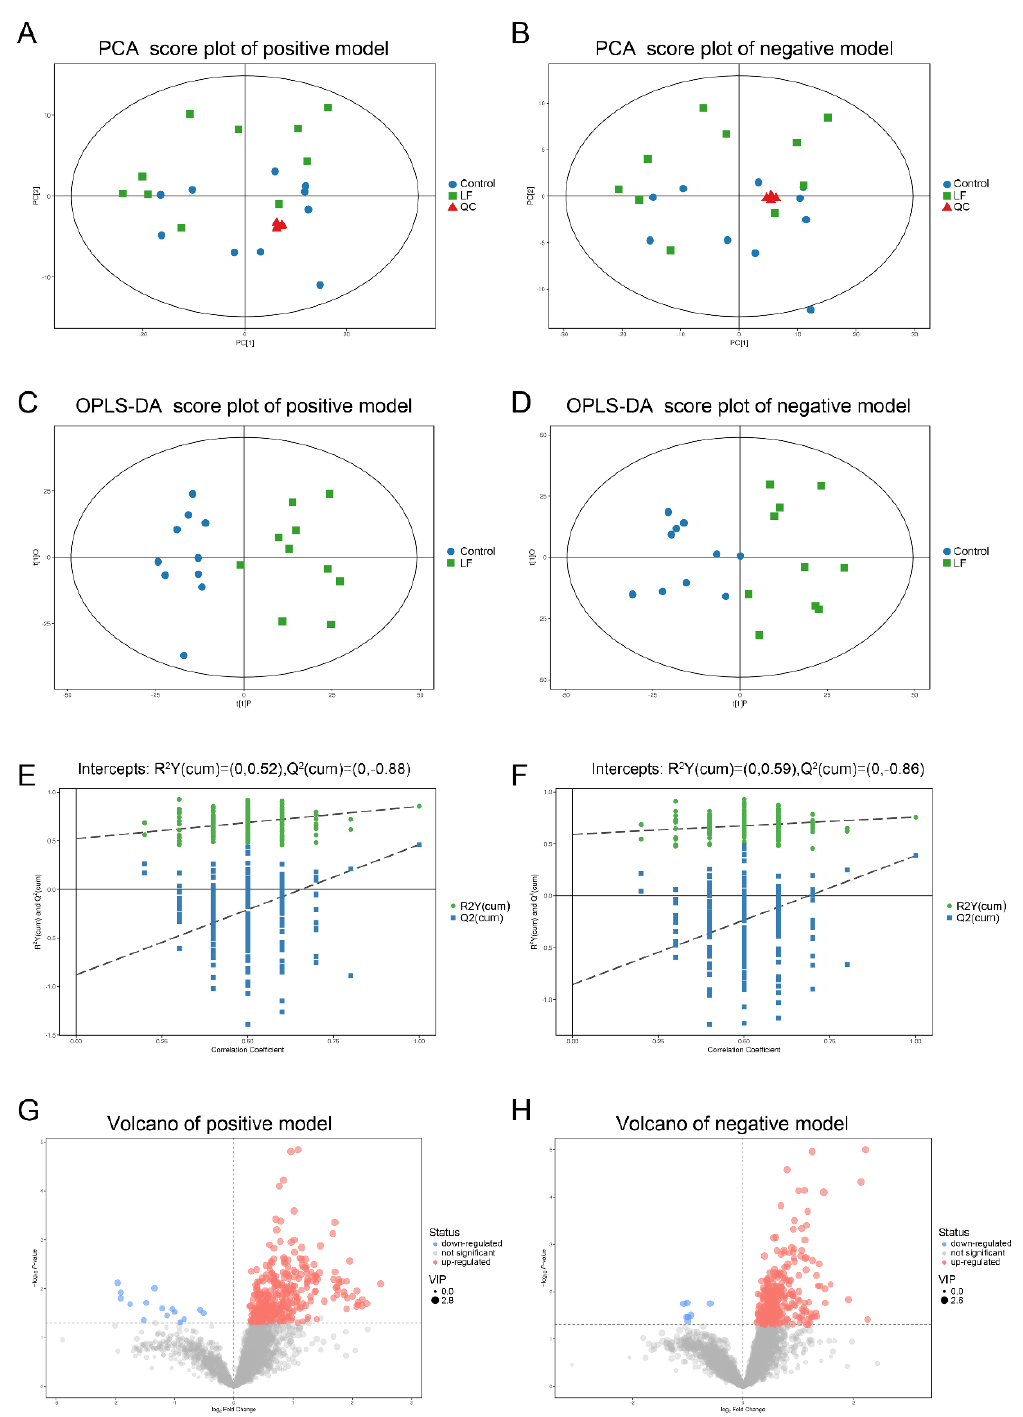
Figure 3. Multivariate analyses of urinary metabolic profiles of rats in the control and lactoferrin groups. ( A , B ) Principal component analysis (PCA) scores were plotted using positive ( A ) and negative ( B ) ion mode datasets for the control and lactoferrin groups and QC. PC[1], Component 1; PC[2], Component 2. Blue circles are the control group; green diamonds are the lactoferrin group; and red triangles are QC. ( C , D ) Orthogonal projections to latent structures–discriminate analysis (OPLS-DA) score plots of urinary metabolites in the control and lactoferrin groups obtained using positive ( C ) and negative ( D ) ion mode datasets. ( E , F ) Permutation test ( n = 200) of OPLS-DA model in positive ( E ) and negative ( F ) ion modes. ( G , H ) Volcano plot of LF e ff ects on urinary metabolites ( p < 0.05; VIP > 1) in positive (( G ), 370 metabolites) and negative (( H ), 298 metabolites) ion